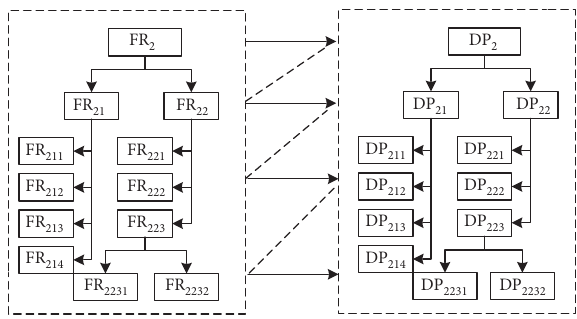
Figure 9: The zigzag mapping of FR